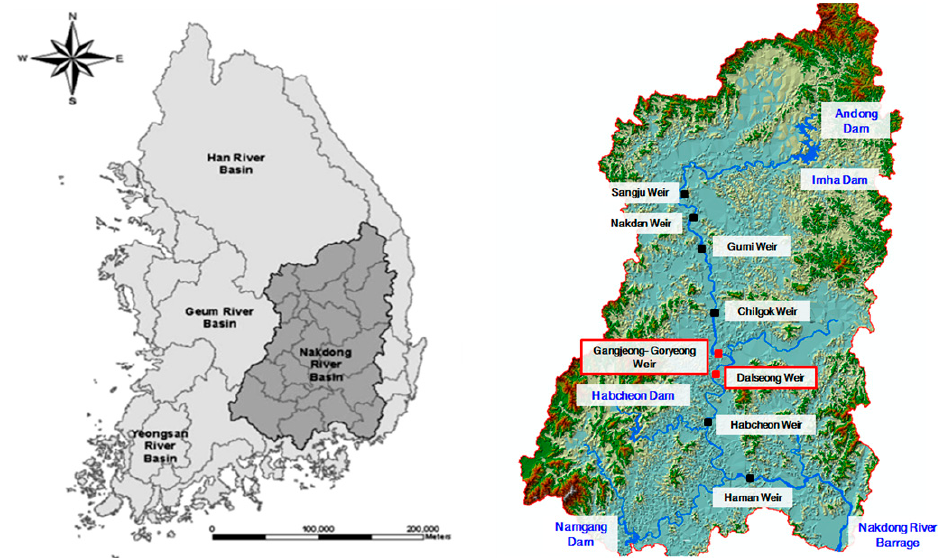
Figure 2. Gangjeong-Goryeong Weir and Dalseong Weir Section in Study Area.